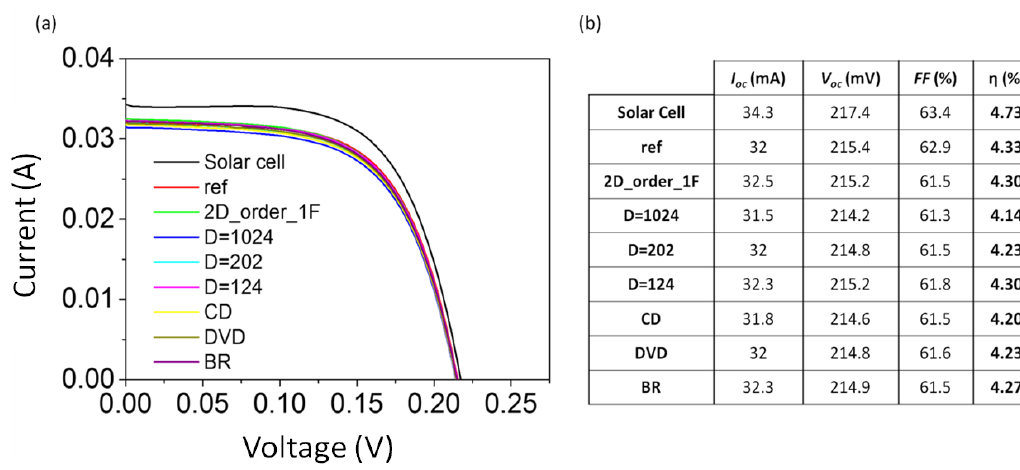
Figure 8. ( a ) I - V curves recorded for a solar cell with different nanostructured cover glasses (2D_ordered_2F, D = 1024, D = 202, D = 124, CD, DVD and BR), with a conventional cover glass (ref), and without cover glass (solar cell) in a solar simulator. ( b ) Values of fill factor ( FF ) and solar efficiency ( η ) obtained from I - V curves.